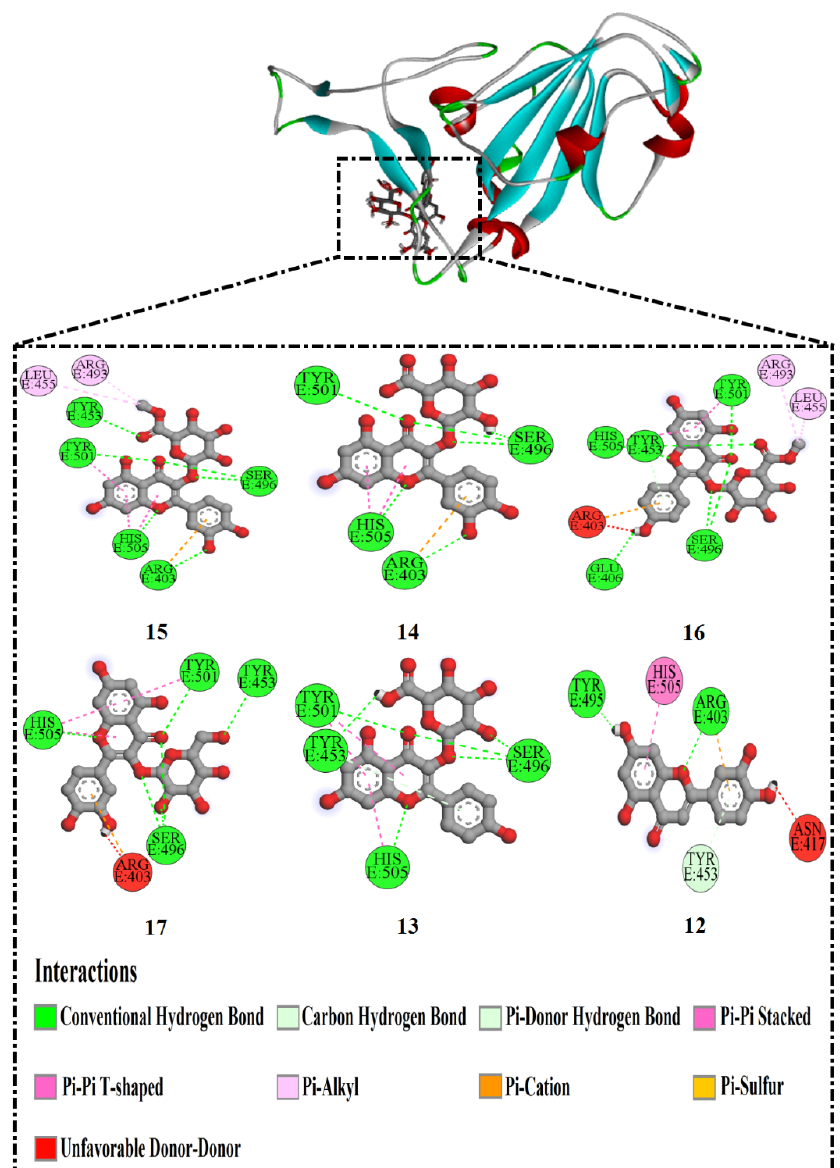
Figure 1. Two-dimensional representations of the anticipated binding poses of the best-investigated drugs inside the active site of